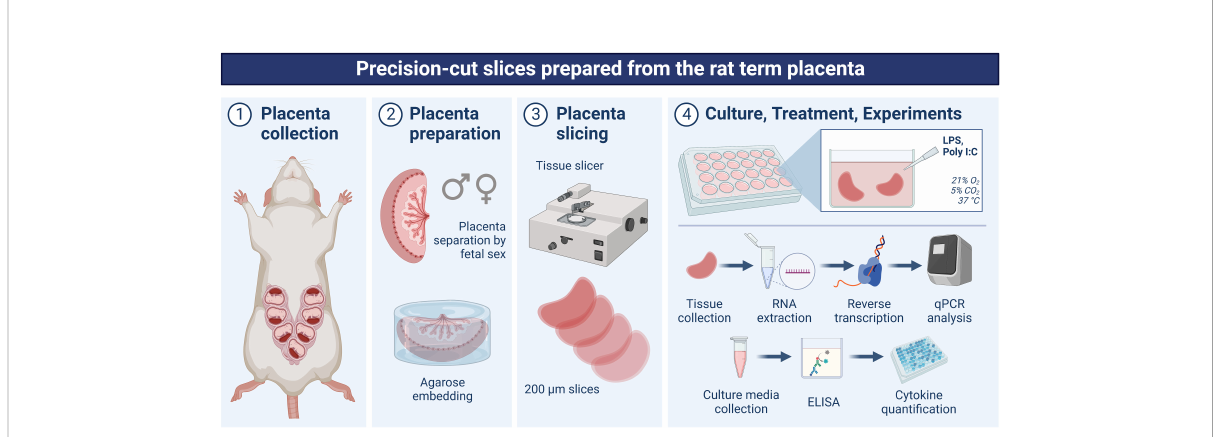
FIGURE 1 Schematic depiction of the experimental design used in this study. On gestation day 20, rats were anesthetized, and the uterine horns were exposed using a midline abdominal incision. Gestational sacs were separated, and placental samples were divided based on the fetal sex. Whole placentas were embedded in agarose, and placental slices with a thickness of 200 µm were generated using a sterilizable microtome. Slices were cultured in 24-well plates for 36 hours (stabilization period) and then exposed to various concentrations of LPS (0.1, 1, 5 µg/ml) or Poly I:C (1, 10, 50 µg/ml) for 4 and 18 hours. After the treatment, the tissue and the culture media were collected for qPCR and ELISA measurements, respectively. Created in